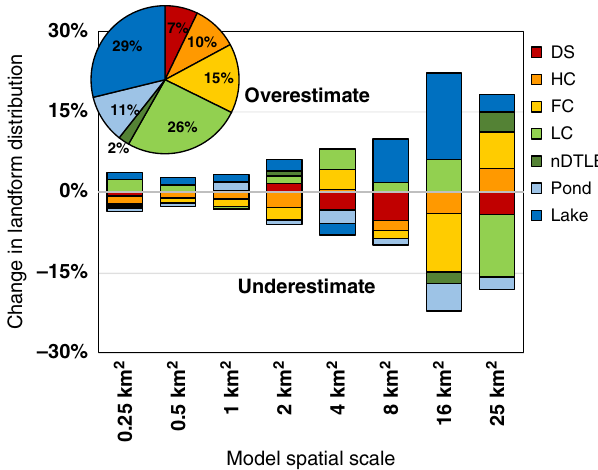
Fig. 6 Misrepresentation of polygonal tundra landforms with scale. Differences in landform distribution across spatial scales are relative to the highest resolution (0.0009 km 2 ; pie chart). Data are representative of mean landform distributions across six subregions on the Barrow Peninsula. Negative and positive values indicate an overestimate and underestimate of polygonal tundra landforms, respectively.